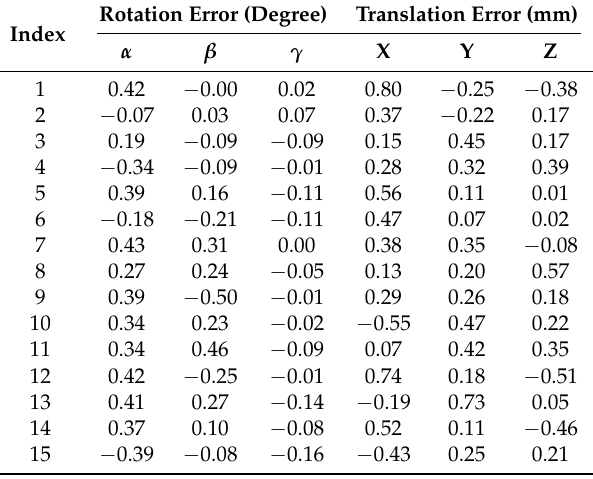
Table 3. The measurement error of workpiece in the second